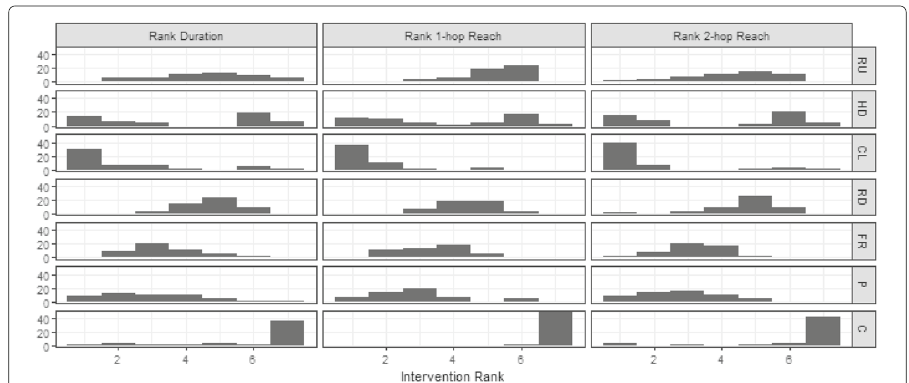
Fig. 1 The average of each output variable is calculated over the set of simulations with the same intervention, network and transmission probability. The interventions are then ranked within the network and threshold combination, with equal effectiveness assigned equal rank. The chart summarises the 51 rankings (17 networks, 3 transmission probabilities) with rank of 1 (best) at the left